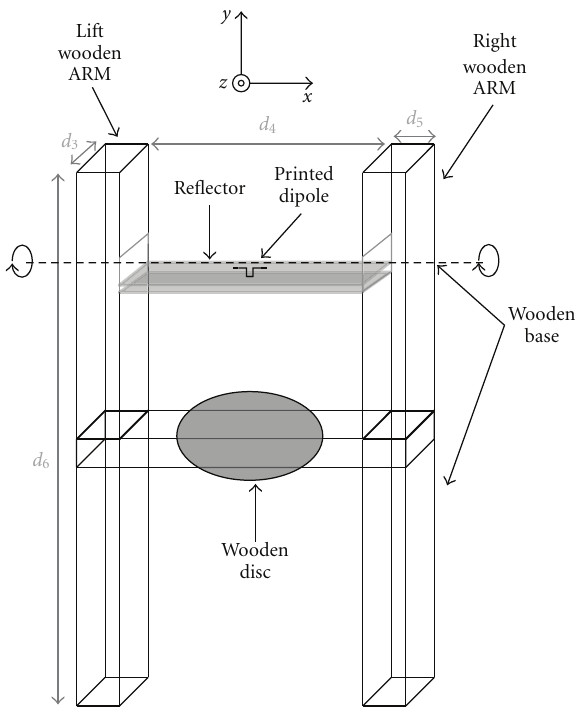
Figure 7: Schematic of the proposed antenna